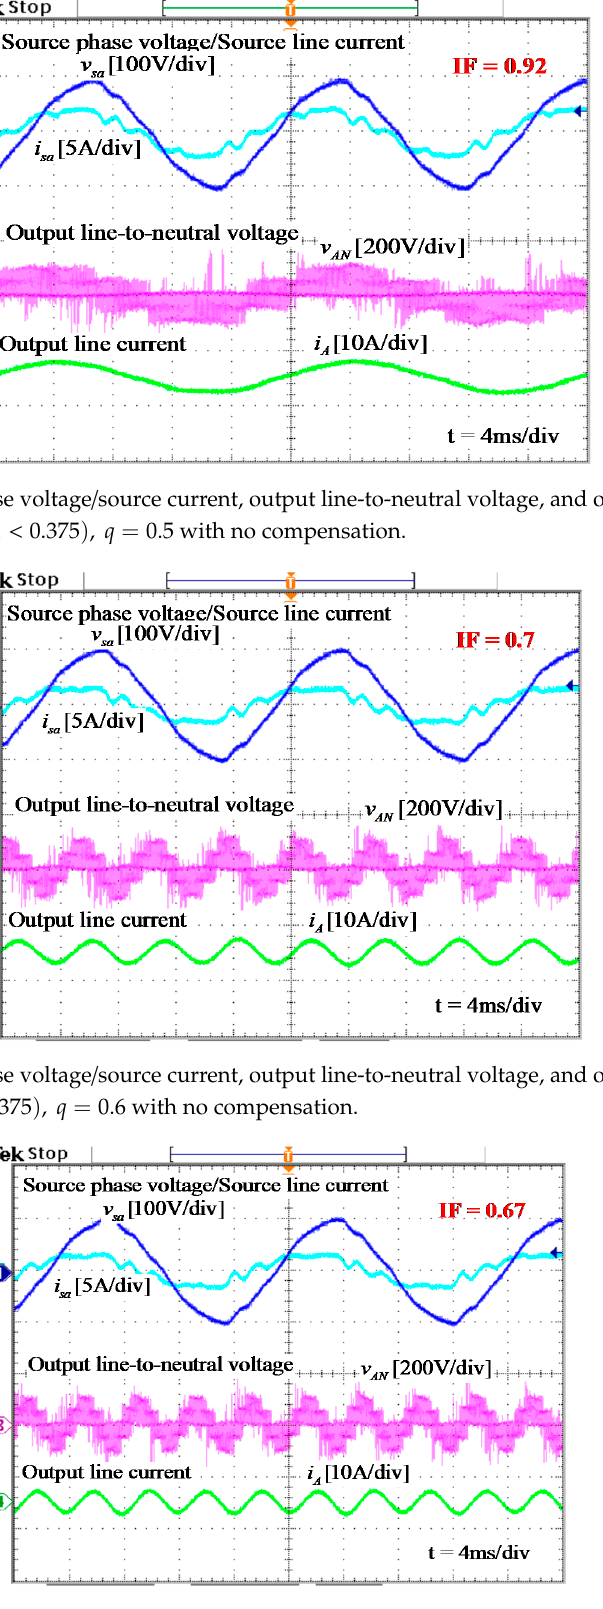
Figure 14. Source phase voltage/source current, output line-to-neutral voltage, and output line current at